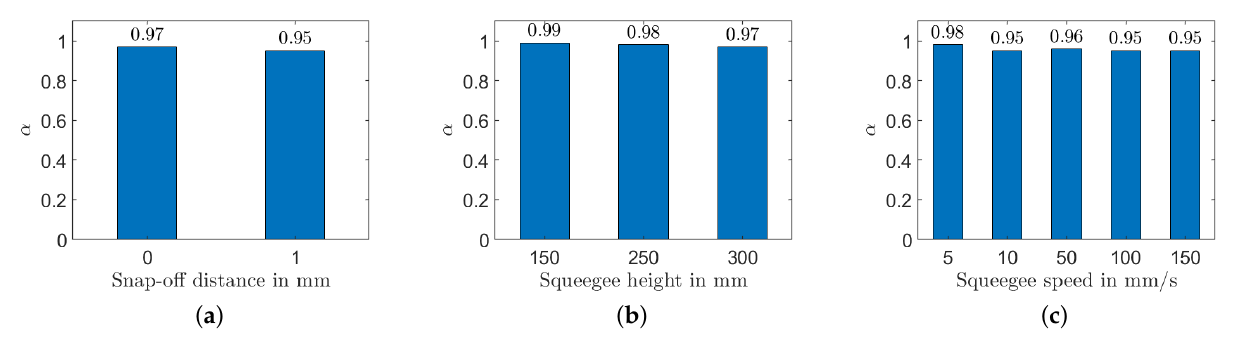
Figure 12. Influence of different screen-printing parameters on the CPE coefficient α : ( a ) snap-off distance; ( b ) squeegee height; ( c ) squeegee